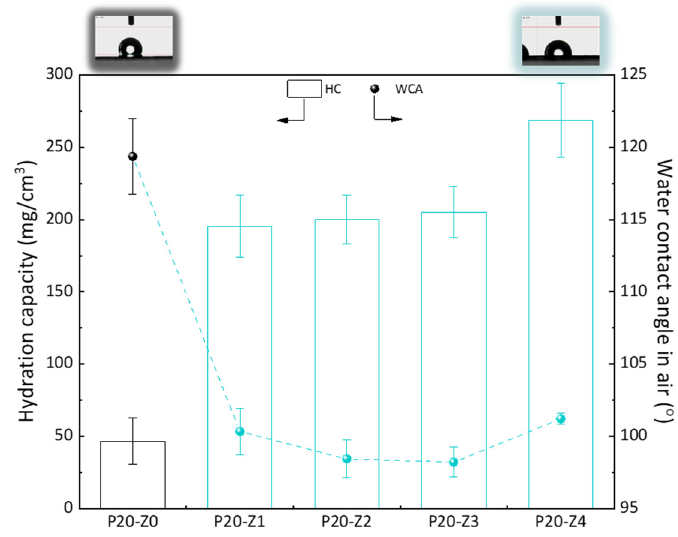
Figure 8. Hydrophilic properties of